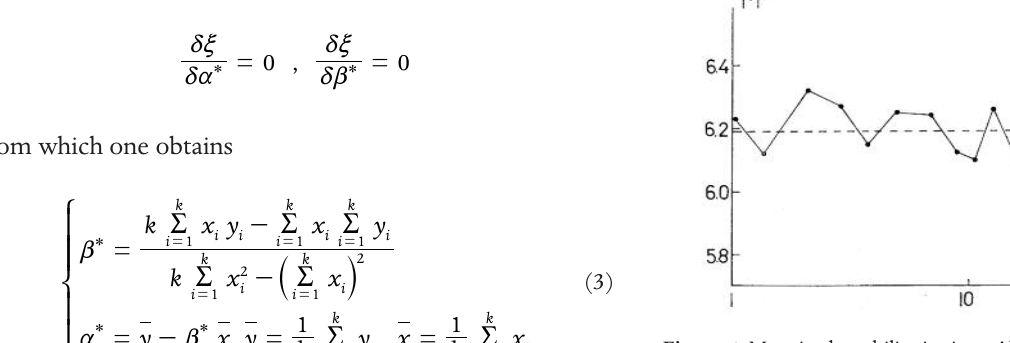
Figure 6. Magnitude stability in time: Aleutin Islands.